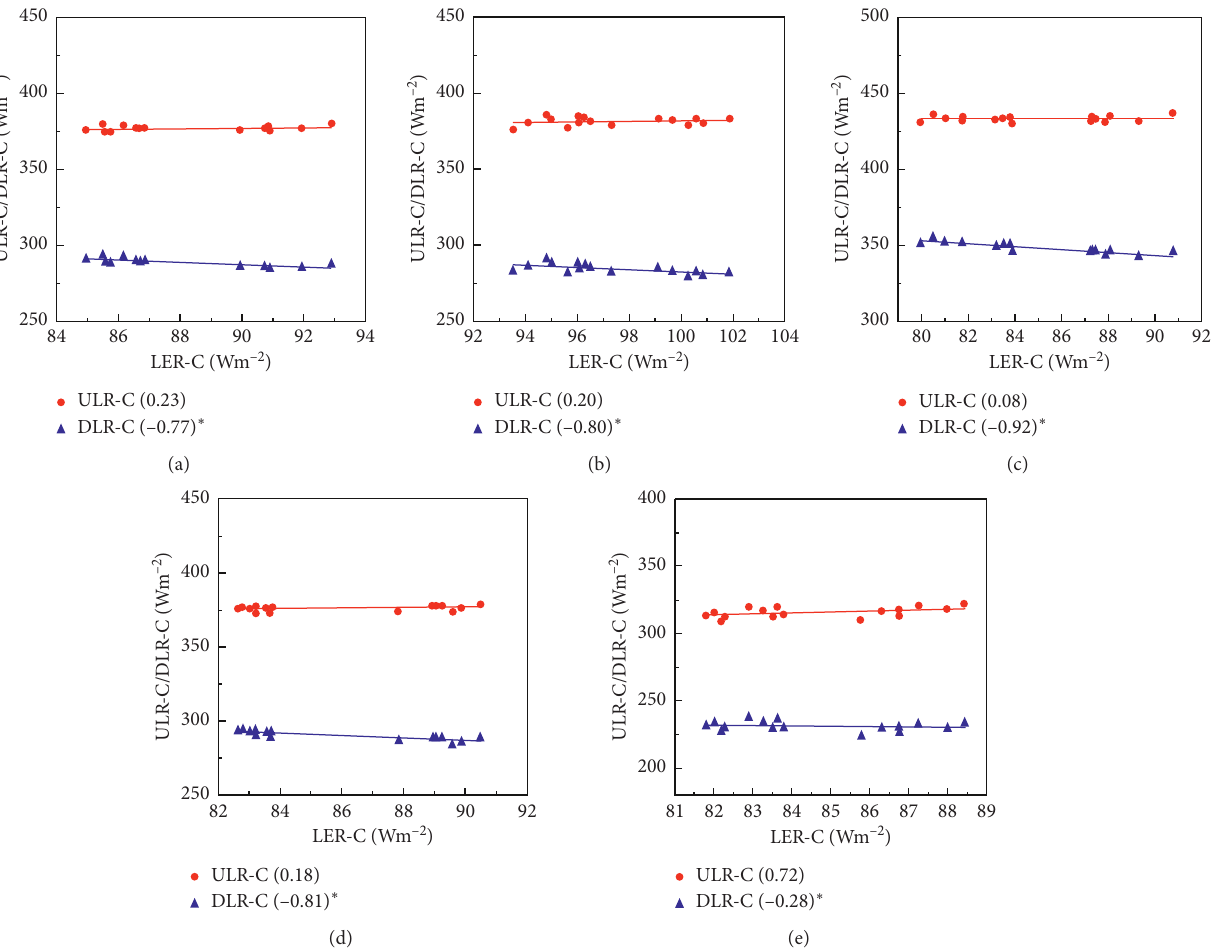
Figure 7: Slopes of annual and seasonal linear regressions for relationship between LER and ULR (red) and DLR (blue) under clear-sky conditions during the period 2001–2016 (LER-C, ULR-C, and DLR-C are radiation fluxes under clear-sky conditions): (a) annual, (b) spring, (c) summer, (d) autumn, and (e)